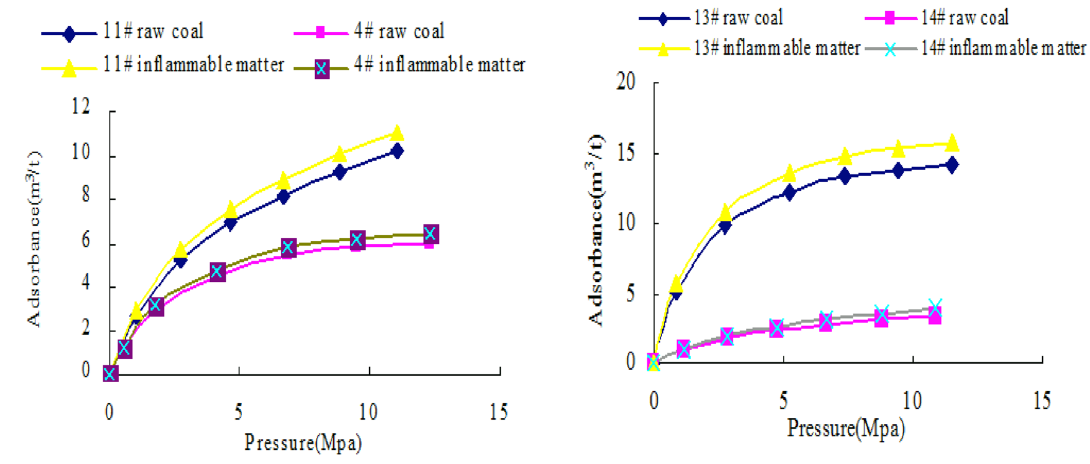
Fig. 5 Methane isothermal adsorption curve of low-rank coal reservoirs in Junggar Basin, NW